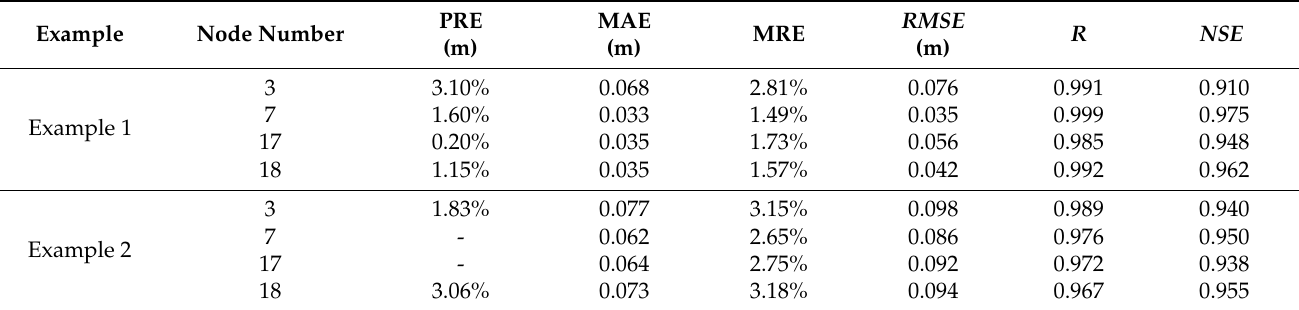
Figure 11. Scatter diagram of the measured and simulated river level. Table 8. Statistical indexes for model validation of the water level.